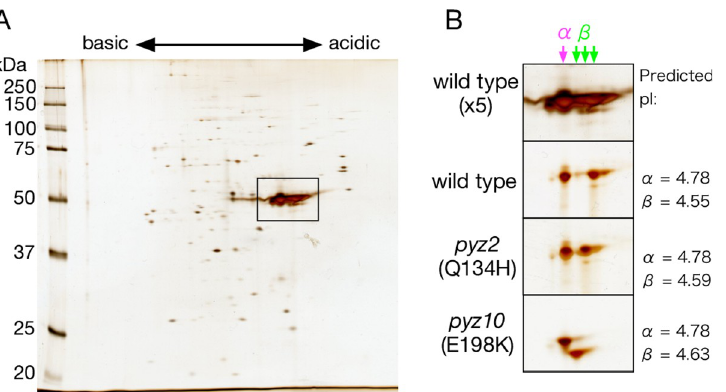
Fig 6. Two-dimensional polyacrylamide gel electrophoresis analysis of axonemes from strains pyz2 and pyz10 . Protein extracts of axonemes of wild type (CC-125), pyz2 and pyz10 were loaded on a two-dimensional polyacrylamide gel and stained with silver. pH range: 4.0–7.0. (A) Electrophoresis pattern of wild-type axoneme (~10 μ g loaded). (B) Portions of polyacrylamide gels showing the major spots of α - and β -tubulin. Upper panel shows a close-up of the area indicated by the box in (A). The lower three panels show the polyacrylamide gels after loading approximately 2 μ g of axoneme. The predicted pIs of the wild-type and three mutant α - and β -tubulins are indicated to the right of the